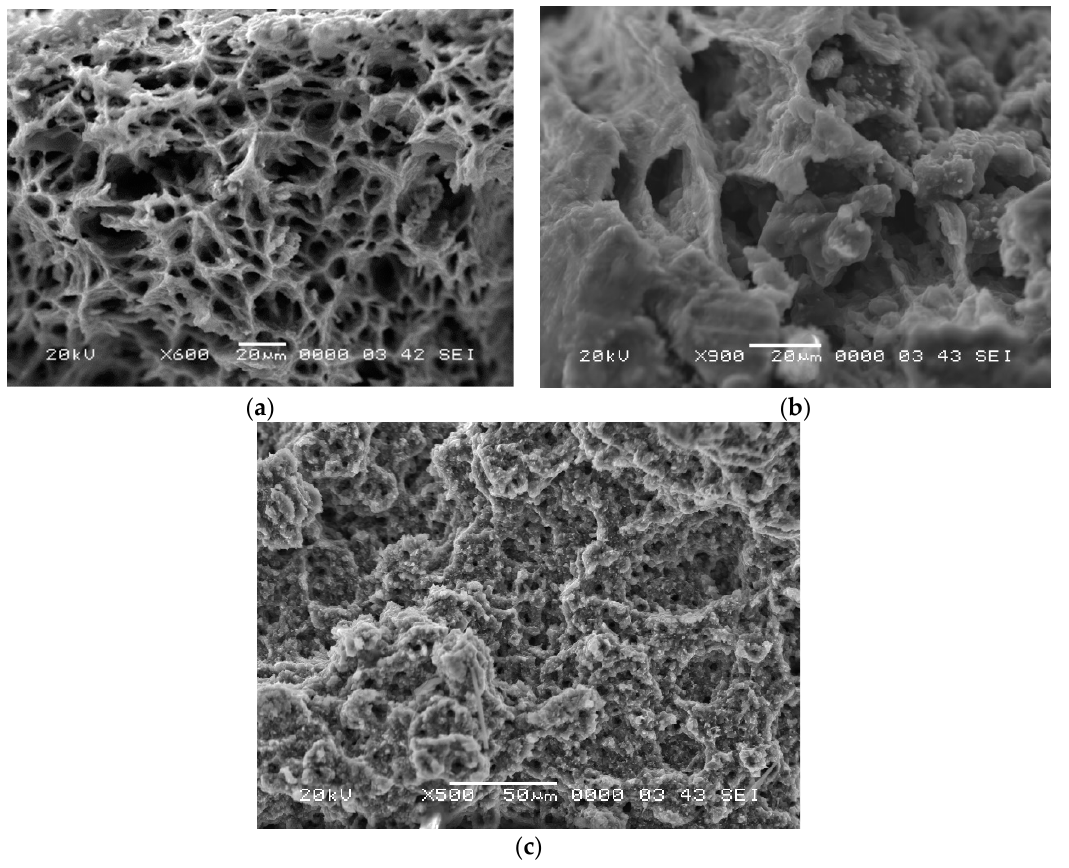
Figure 15. Fracture surface of DMD processed AZ31-2Ca alloy specimen tested in uniaxial tension in ( a ) 350 ° C/0.001 s − 1 (Domain #1A); ( b ) 450 ° C/0.0003 s − 1 (Domain #1); and ( c ) 400 ° C/1 s − 1 (Domain #2), showing ductile fracture.